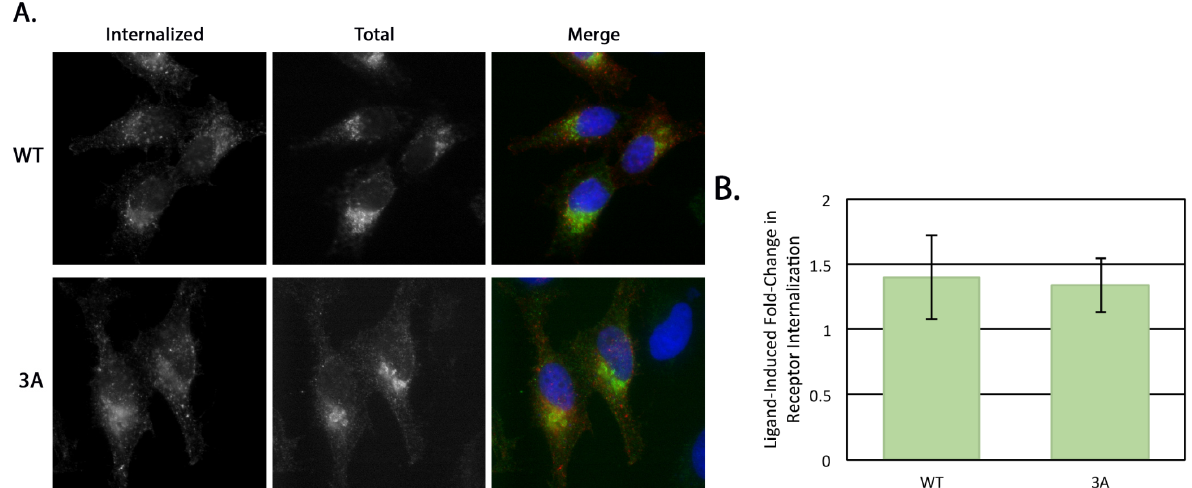
Figure 5. Internalization of β 1AR from the plasma membrane is not affected by the 3A mutation. ( A ) Representative images of internalized β 1AR WT or 3A following 30 min stimulation by Iso. HeLa cells expressing FLAG-tagged β 1AR WT or 3A were serum starved for 3 h before receptor internalization was analyzed. Mouse anti-FLAG antibodies which recognize the exposed FLAG-tag were added to the serum free DMEM for 30 min, with or without the agonist Iso to induce internalization. Cells were then briefly acid washed to remove antibody from receptors still at the cell surface before they were fixed, permeabilized and labeled with a fluorescent secondary antibody to detect internalized antibody. The total internal pool of β 1AR was detected using a rabbit antibody to the cytoplasmic C -terminus. Merge: red, anti-FLAG (internalized); green, anti- β 1AR (total); blue, DNA stained with Hoechst 33258; ( B ) Internalization of β 1AR WT or 3A was quantified as the fold-change of agonist-stimulated internalization over unstimulated. The fluorescent signal (integrated pixel density) was measured for each cell; only cells expressing similar levels of total β 1AR were compared. Error bars represent standard deviation, p =